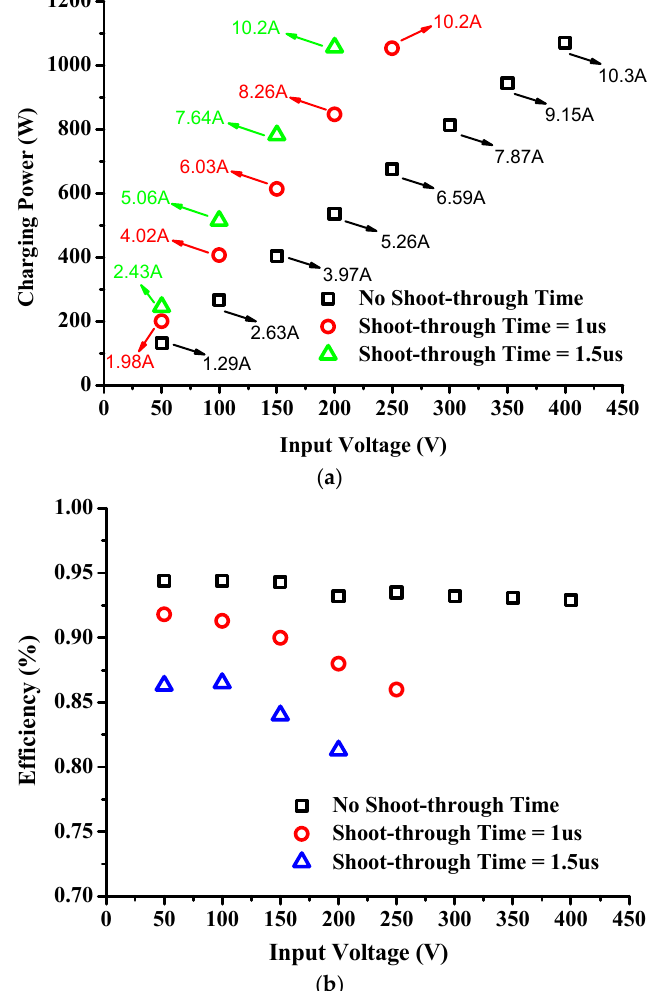
Figure 18. Wireless transfer power ( a ) and efficiency ( b ) characteristics based on the q ‐ Zsource voltage boosting method at 20 cm transfer distance.